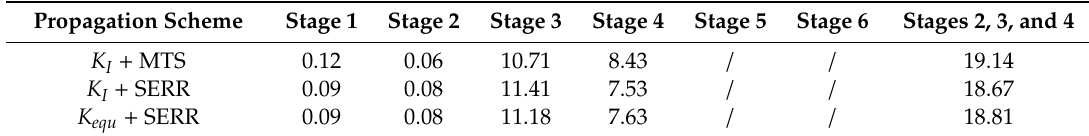
Table 7. Propagation depth of di ff erent stages